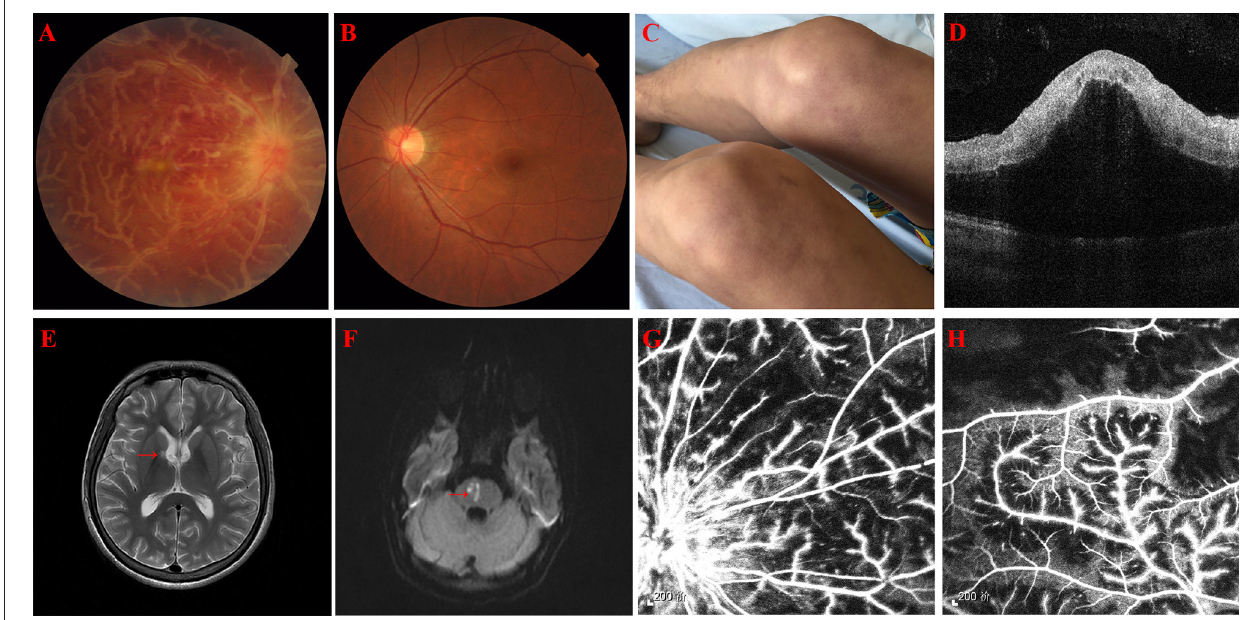
FIGURE 1 | (A) A fundus photograph of the right eye showing thick, white confluent sheathing around retinal veins suggestive of frosted branch angiitis, disc hyperemia, and macular edema. (B) A fundus photograph of the left eye showing normal appearance. (C) Recurrent skin rash on both thighs. (D) Optical coherence tomography of the right eye showing exudative macular detachment, vitreous cells, and posterior vitreous detachment. (E) Old lacunar infarction involving the right basal ganglia and the lateral ventricle (red arrow) in magnetic resonance (MR) T2 phase, but not in the diffusion-weighted imaging (DWI) (image not showed). (F) Fresh lacunar infarction in the right pons (red arrow) in MR DWI. (G,H) Fluorescein angiography of the right eye showing extensive vascular leakage and supratemporal capillary non-perfusion